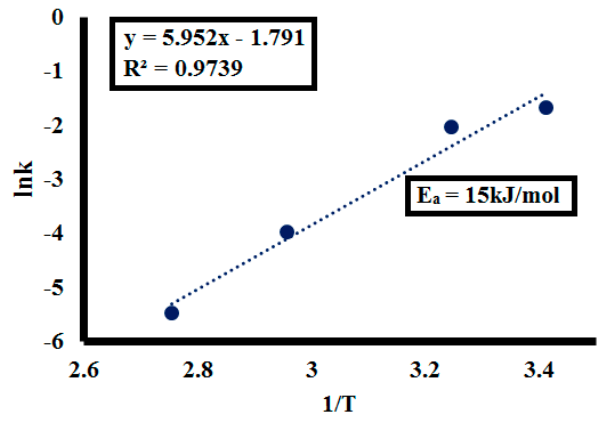
Figure 18. Arrhenius Law on temperature data.